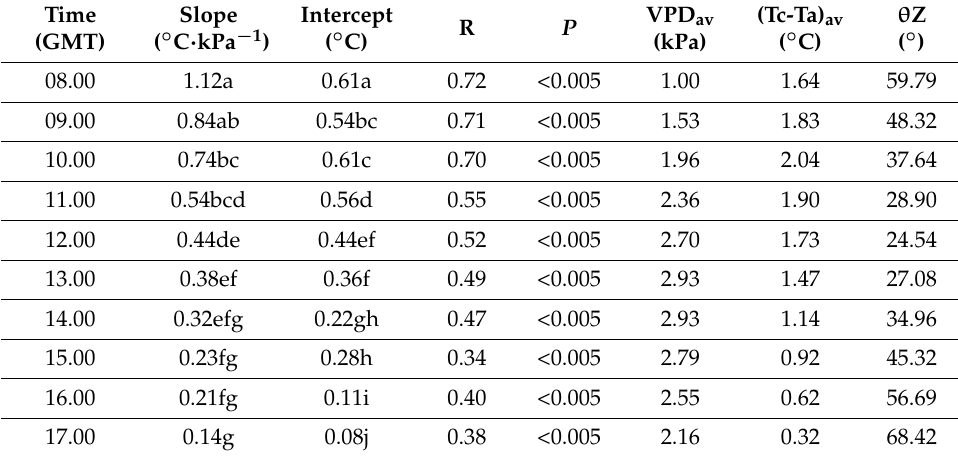
Table 2. Significant hourly correlations between Tc-Ta versus VPD using cloudless days of year (DOY) 193–257 for the non-water stressed baseline (NSWB). GMT: Greenwich Mean Time. VPD: Vapor pressure deficit. θ Z: zenith solar angle. The suffix av indicates the average. Each value is obtained from hourly Tc-Ta and VPD average in a given day at a given hour, using the Tc of the fully irrigated trees (TW-FI). Number of points for each regression was 53. Different letters within the same column indicate significant differences among Time (GMT), according to ANCOVA ( P < 0.01).